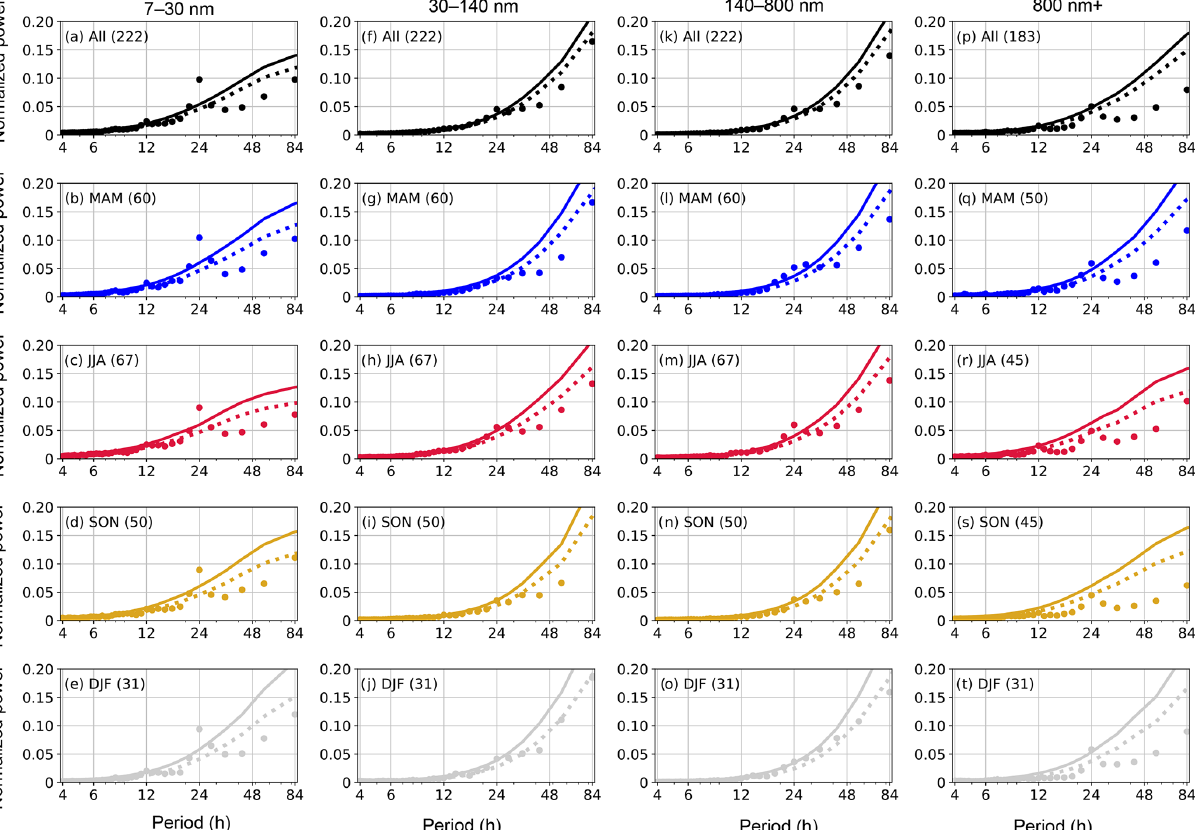
Figure 10. Normalized power spectra for V 7 − 30nm , V 30 − 140nm , V 140 − 800nm , and V 800nm + for the entire period and by season. The descriptions of the symbols used are the same as in Fig.